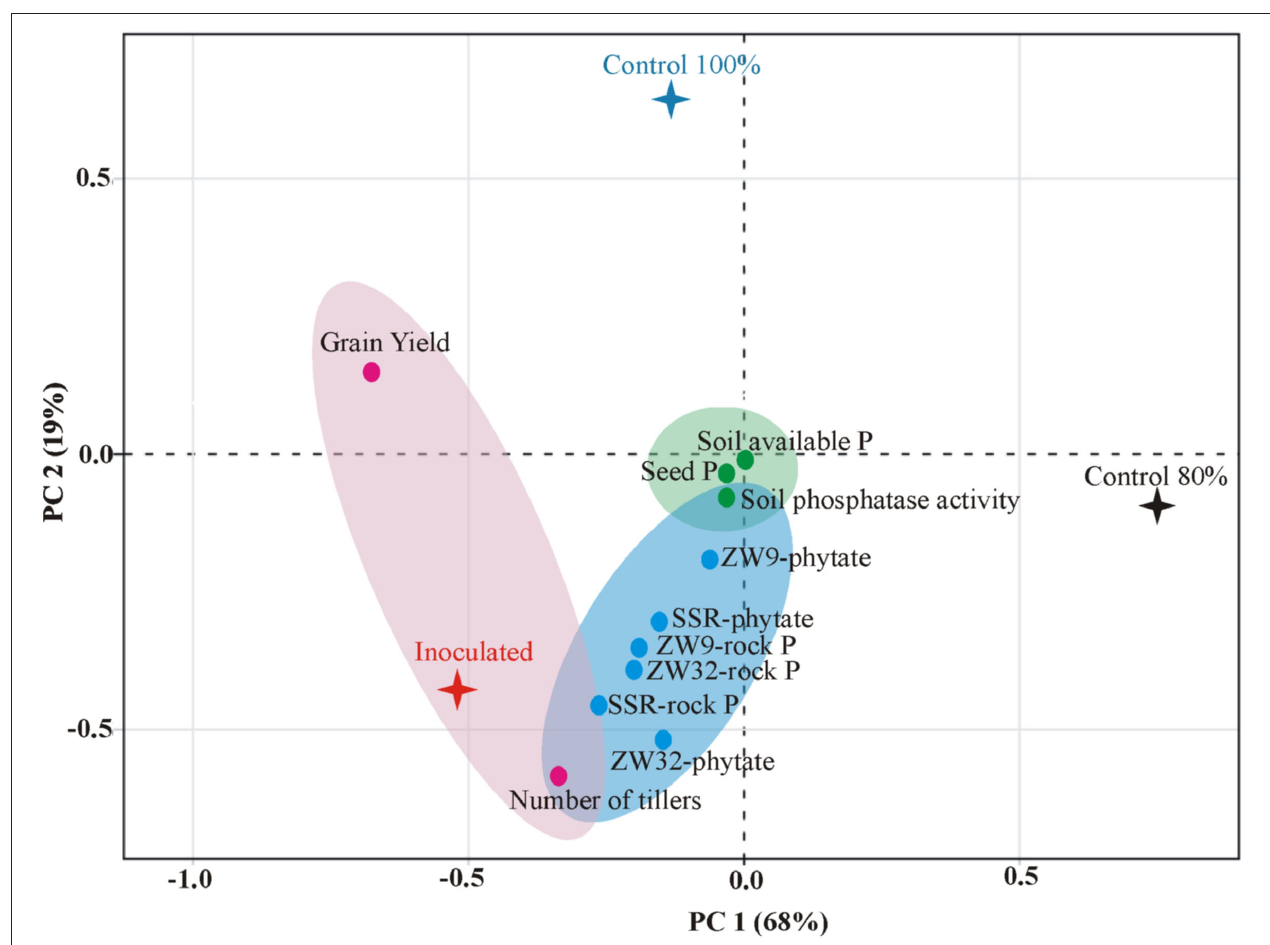
FIGURE 6 | Principal component analysis depicting the response of PSB inoculation to wheat yield parameters, plant, and soil P content. The components elucidate a total variance of 87%. The points represent mean values of each combination of seed P, wheat yield parameters (grain yield and number of tillers), soil P contents (available P and phosphatase activity), and the treatments (PSB inoculation and un-inoculated